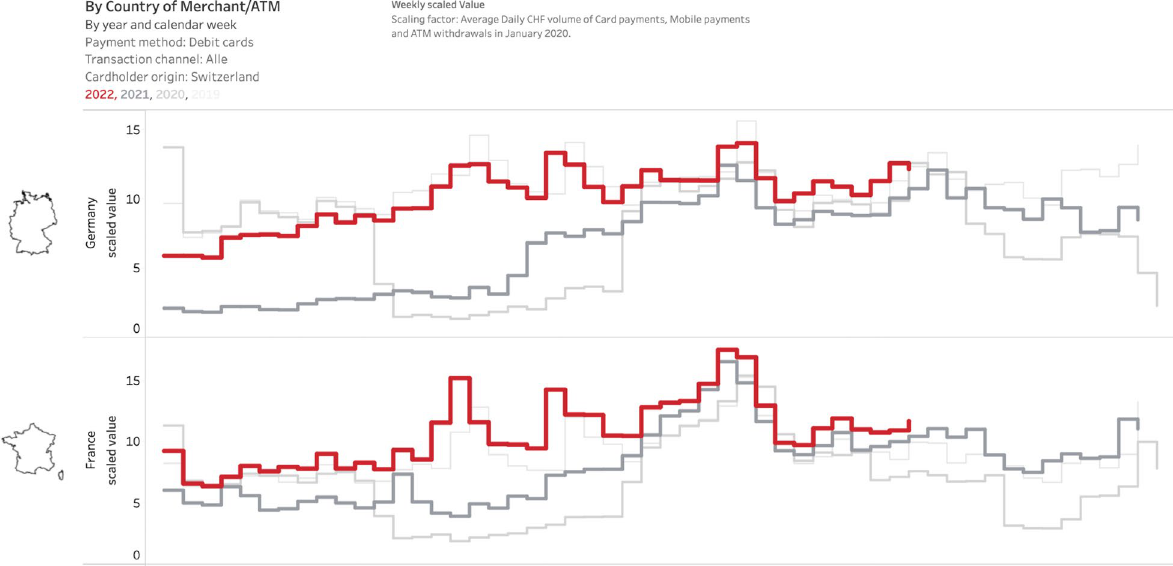
Fig. 12 Cross-border debit card transactions by Swiss consumers in Germany/France. Note : The figure displays weekly scaled payment transactions with debit cards issued by Swiss banks for 2020–2022. Transactions include payments at PoS terminals and cash withdrawals at ATMs. Spending in Germany is displayed in the upper panel, spending in France in the lower panel. We display the data as provided, i.e., as a scaled value, which preserves the relative interpretability both over time and in the cross-section. See Sect. 2 for more details. Data source: Debit_Merchanttype_